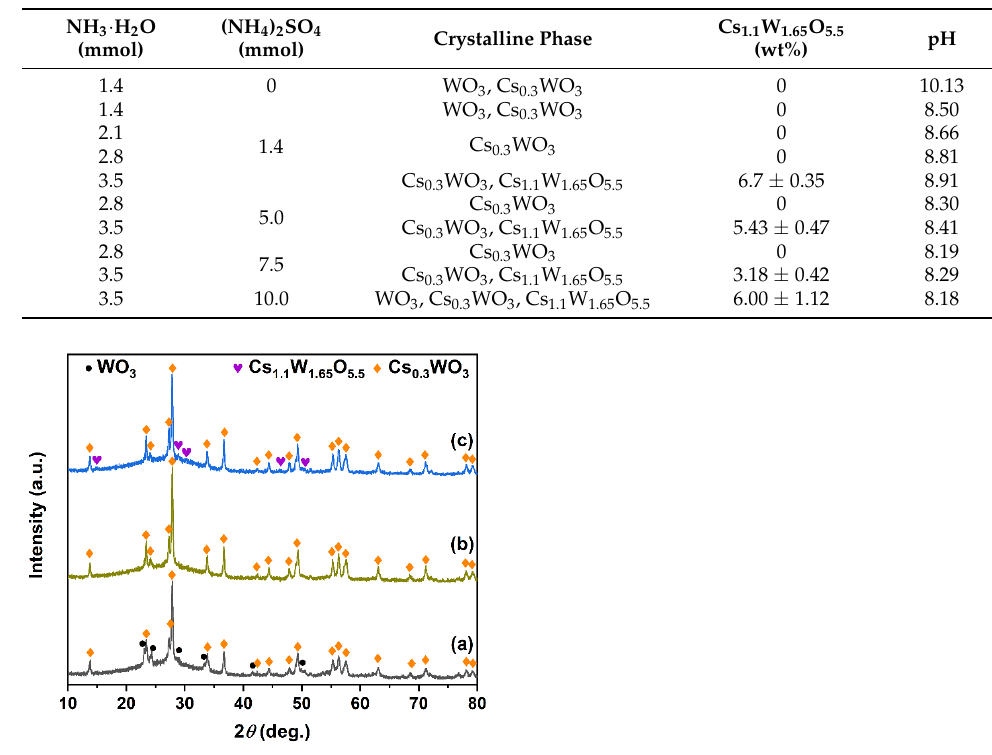
Figure 1. XRD patterns of the samples synthesized hydrothermally at 200 °C for 24 h using 0.18 mmol CsCl, 0.4 mmol WO 3 , 8.8 mmol CH 3 CH 2 CHO, 5.0 mmol (NH 4 ) 2 SO 4 , and ( a ) 2.1; ( b ) 2.8; ( c ) 3.5 mmol NH 3 ‧ H 2 O. NH 3 · H 2